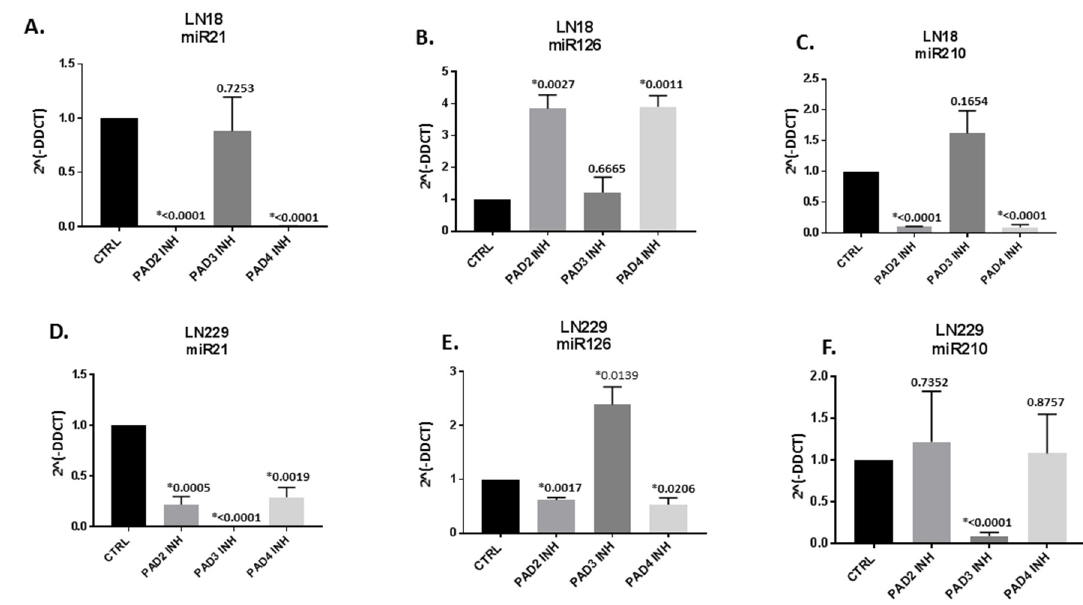
Figure 4. PAD isozyme-specific inhibitor mediated effects on EV microRNA cargo is GBM cell line specific. LN18 cell-derived EVs following 1 h PAD inhibitor treatment are shown in A–C: ( A ) PAD2, 3, and 4 isozyme-specific inhibitor-mediated effects on the pro-oncogenic miR21 in EVs derived from LN18 cells. ( B ) PAD2, 3, and 4 isozyme-specific inhibitor mediated effects on the anti-oncogenic miR126 in EVs derived from LN18 cells. ( C ) PAD2, 3, and 4 isozyme-specific inhibitor mediated effects on the hypoxia-related and pro-oncogenic miR210 in LN18 cells. LN229 cell-derived EVs following 1 h PAD inhibitor treatment are shown in D–F: ( D ) PAD2, 3, and 4 isozyme-specific inhibitor-mediated effects on the pro-oncogenic miR21 in EVs derived from LN229 cells. ( E ) PAD2, 3, and 4 isozyme-specific inhibitor mediated effects on the anti-oncogenic miR126 in EVs derived from LN229 cells. ( F ) PAD2, 3, and 4 isozyme-specific inhibitor mediated effects on the hypoxia-related and pro-oncogenic miR210 in LN229 cells. Results are represented as relative miR expression compared to the internal control miRs (2 Λ ( − DDCT)) and normalised to expression in control-treated cells; exact p -values are indicated, error bars show SD (*indicates significant differences with p < 0.05; n = 3 biological and 3 technical replicates for all).